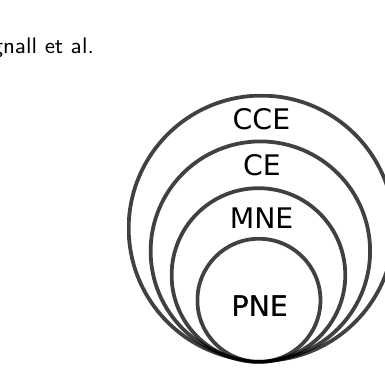
Fig. 1. Equilibrium Refinements. Illustration modeled on [30, Figure